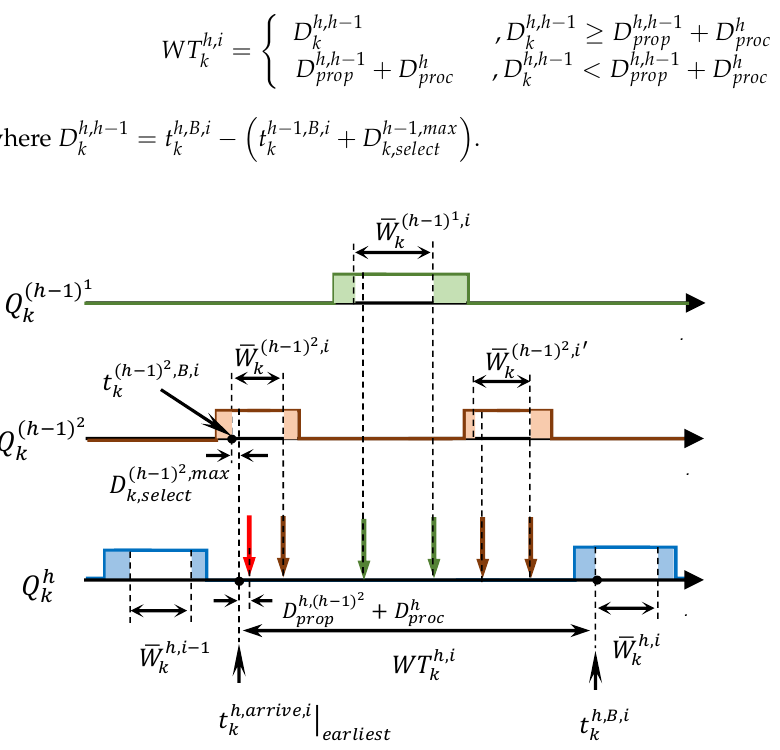
Figure 11. The maximum waiting time at the non-first node in the selected path.